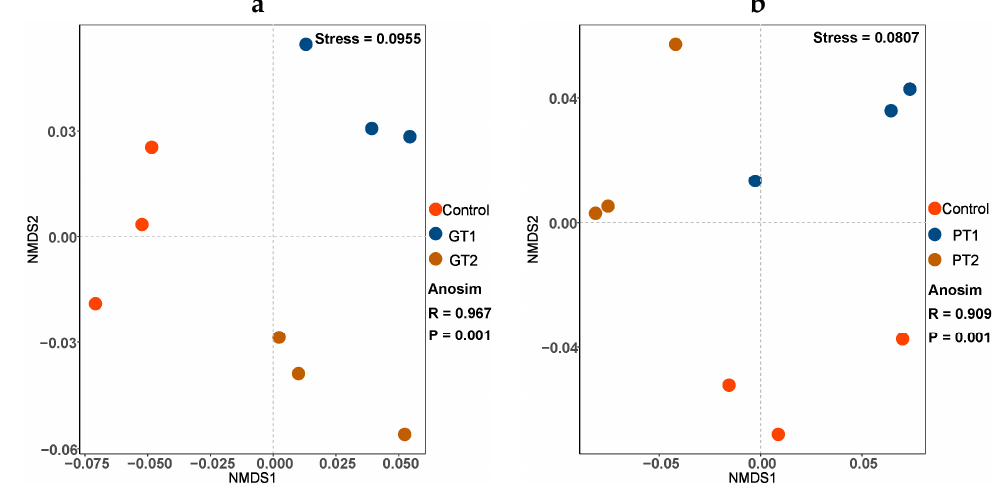
Figure 2. NMDS analysis based on Bray–Curtis distance, displaying the number of bacterial OTUs in BSFL gut shared among the control, GT1 and GT2 treatment groups ( a ), and the control, PT1 and PT2 treatment groups ( b ).